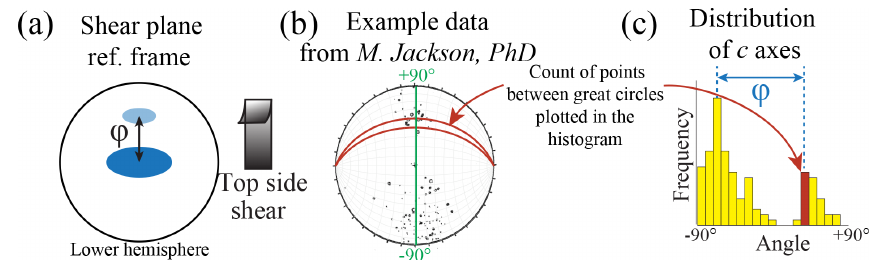
Figure 2. (a) Typical two-cluster distribution of c axes on the stereonets in the shear plane reference frame. (b) A schematic drawing explaining the method used to quantify the distribution of c axes. (c) The distribution of c axes plotted in a histogram, illustrating the angle between the two clusters of c axes, ϕ .